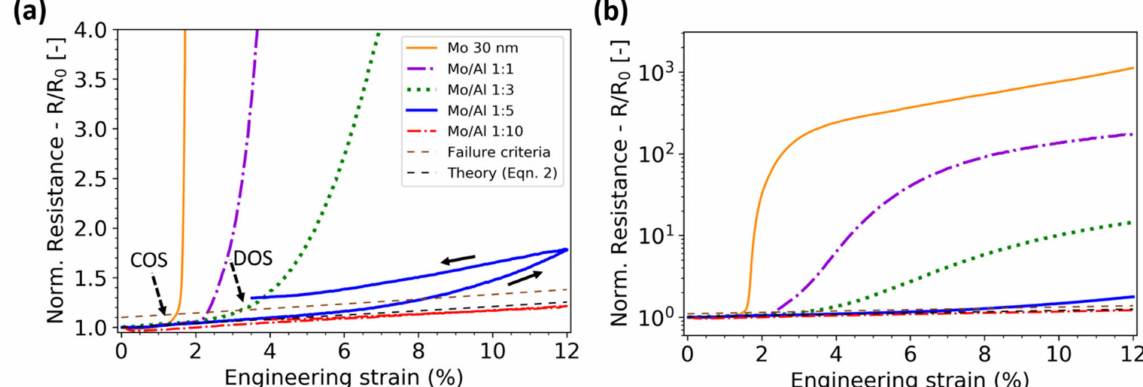
Figure 5. ( a ) Example of brittle and ductile electrical behavior in sputter deposited Mo and Mo/Al bilayers with increasing Al thickness (Mo:Al layer thickness ratio) as a function of applied strain. Deviation from the constant volume approximation generally is referred to as the COS or DOS. Note that the more ductile bilayers have a variety of responses compared to brittle 30 nm Mo film. ( b ) At high applied strains, the resistance does not reach a distinct plateau even though the crack or damage density saturates (note log scale). Only loading data shown for clarity. Data taken from